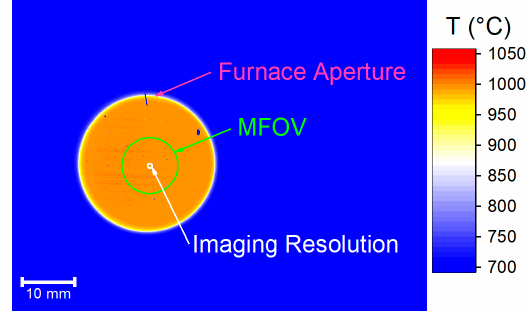
Figure 6. A representative calibration image of the furnace aperture with the furnace at 1000 °C. The three circles respectively show: furnace aperture area, minimum area over which an accurate temperature measurement can be made, and area over which thermal distributions can be resolved.